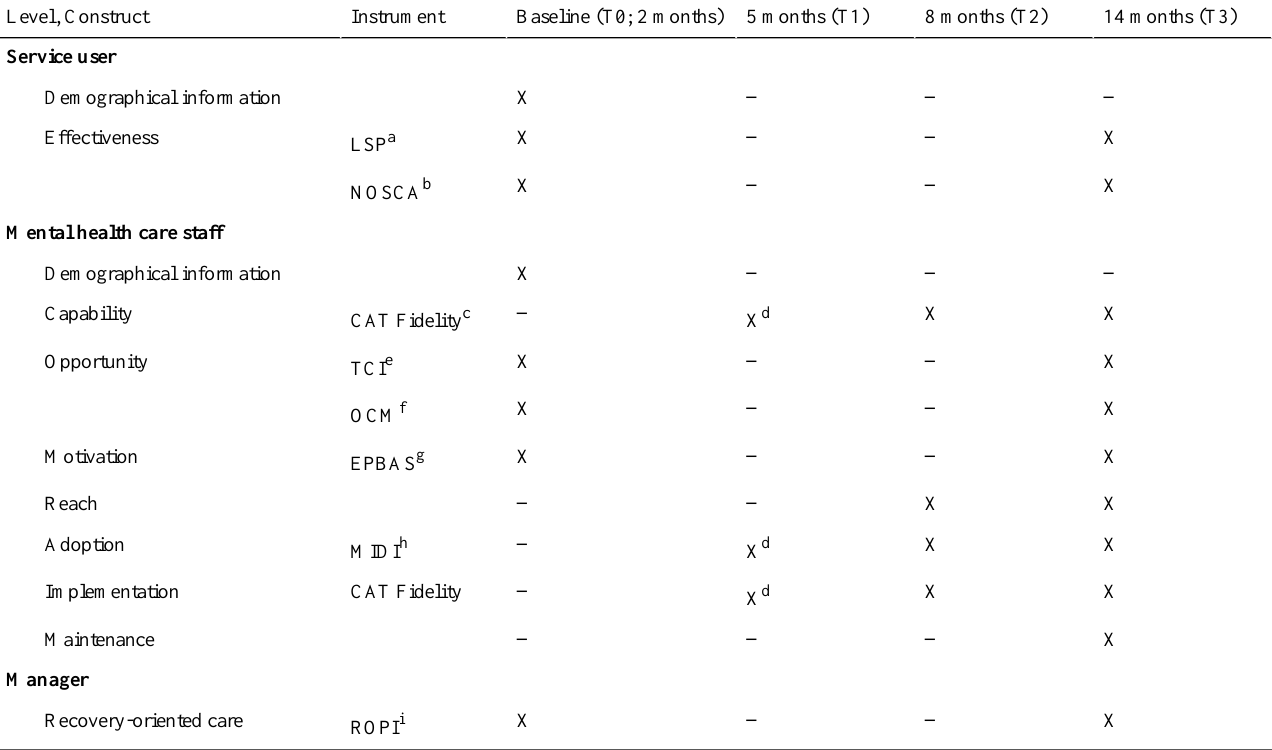
Table 1. Schedule of